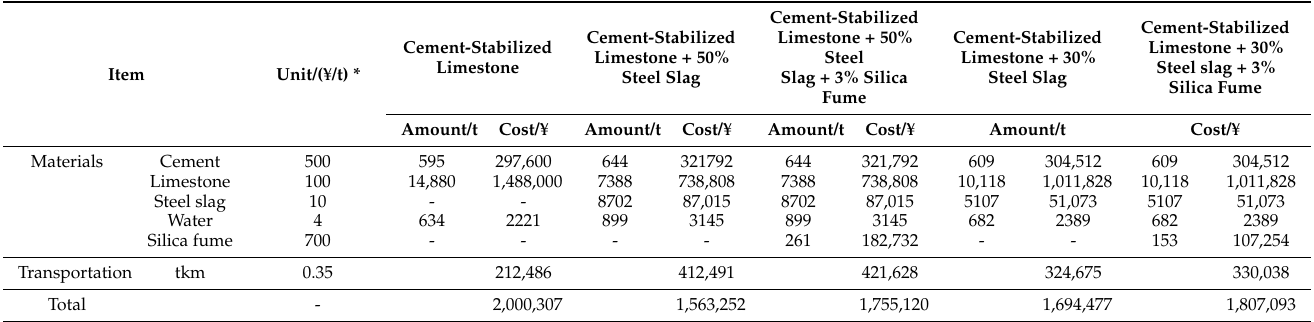
Table 7. Costs of material and transportation.